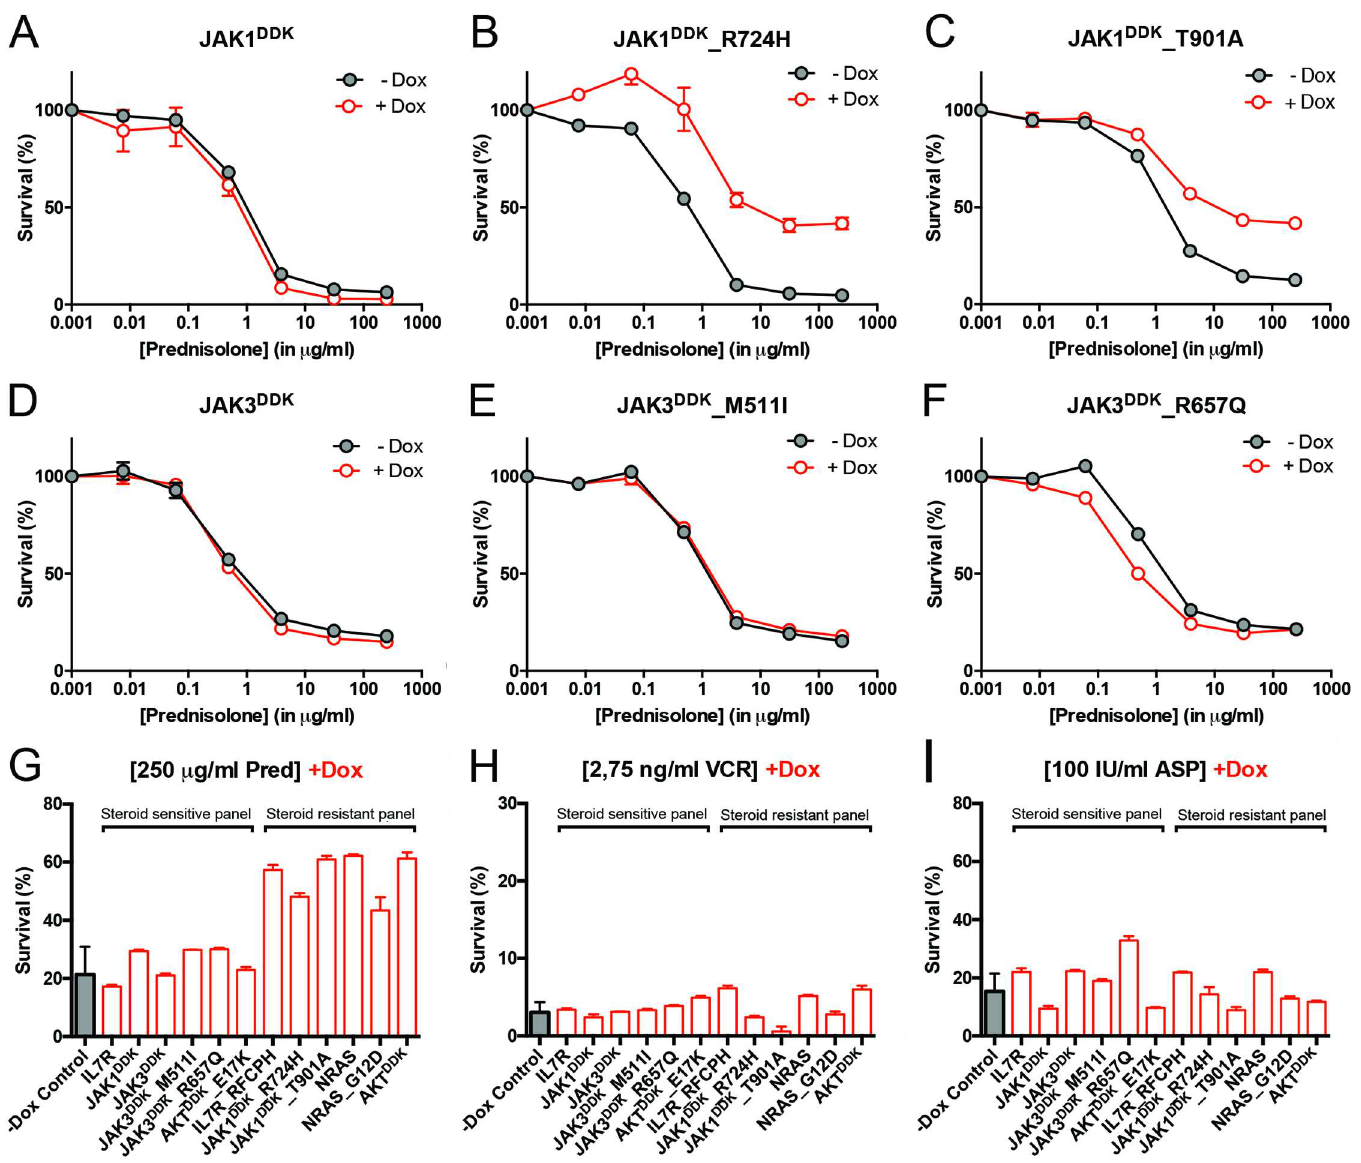
Fig 4. Activating IL7R signaling mutations can confer resistance to steroid treatment. (A–F) Steroid responsecurves (from triplicate experiments ± standarddeviation)for SUPT1 cells that express (A) JAK1, (B) JAK1 R724H , (C) JAK1 T901A , (D) JAK3, (E) JAK3 M511I , or (F) JAK3 R657Q from doxycycline-inducible lentiviral expressionconstructs. Steroid responsecurves are shown for induced(+Dox) and non-induced( − Dox)cells that have been exposedto serialdilutionsof prednisolone for 72 h. (G–I) Mean survival of SUPT1 cells (triplicate experiments ± standarddeviation)expressingwild-typeor mutant IL7R signalingmolecules(+Dox: open red bars) followinga 72-h exposureto (G) prednisolone (Pred), (H) vincristine(VCR), or (I) L -asparaginase (ASP). Black bars represent the mean survival of all SUPT1 lines under non-inducedconditions followingexposure to prednisolone, vincristine,or L - asparaginase ( − Doxcontrol). The steroid-sensitive panel refers to SUPT1 lines that retain a similarlysensitive steroid responsefollowingexpressionof IL7R, JAK1, JAK3, JAK3 M511I , JAK3 R657Q , or AKT E17K comparedto non-induced control conditions. The steroid-resistant panelrefers to lines that acquire